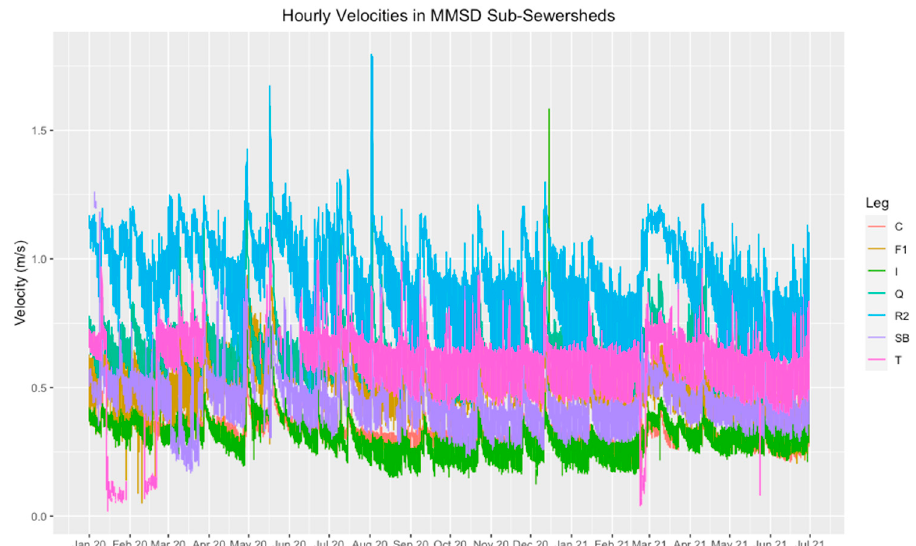
Figure 2. Hourly metered velocity readings from four representative subsewersheds in SS WWTP (within legs Q, R2, SB, T), and three representative subsewersheds in JI WWTP (within legs C, F1, I) over the course of this study.